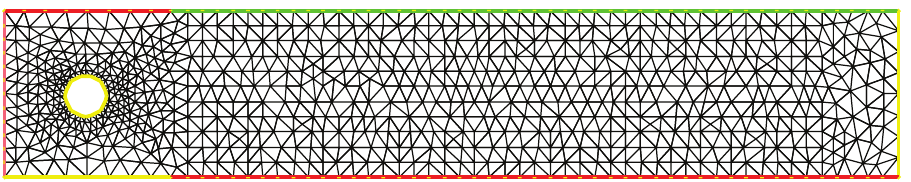
Figure 8. Domain.